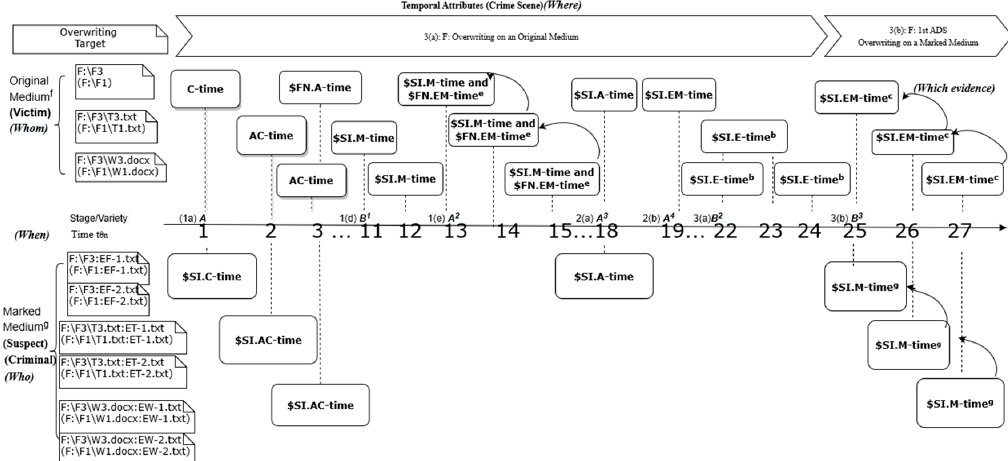
Figure 4. Temporal reconstruction on overwriting timeline (Stage 3). Note: b Rule 2, c Rule 3, e Rule 5, f Rule 6, and g Rule 7.